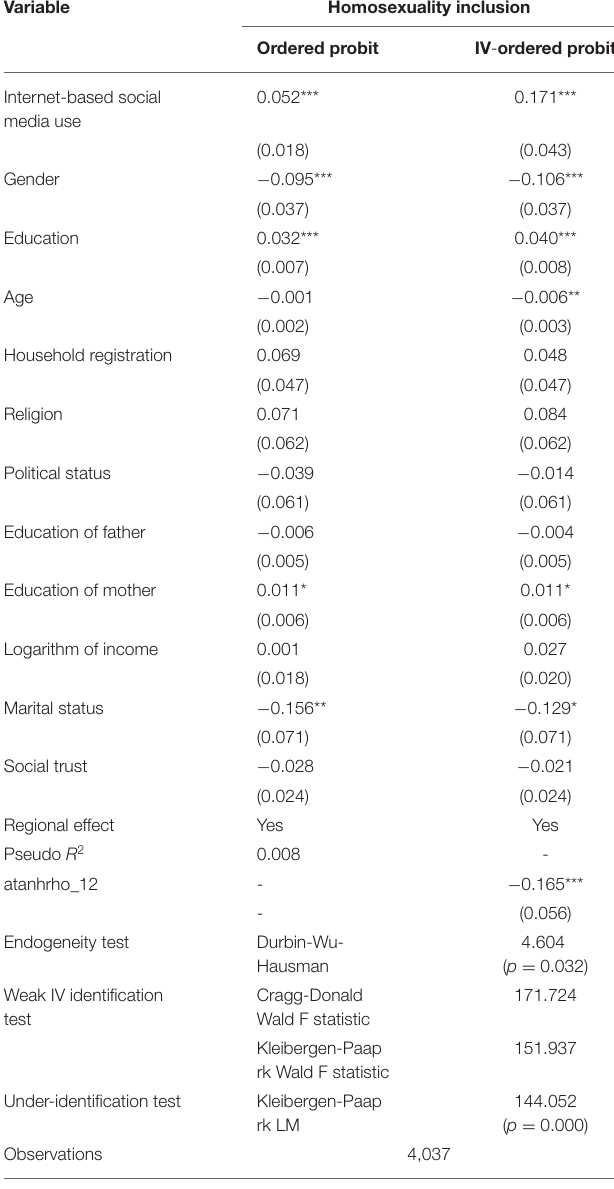
TABLE 2 | Association between internet-based social media use and homosexuality inclusion ( N =